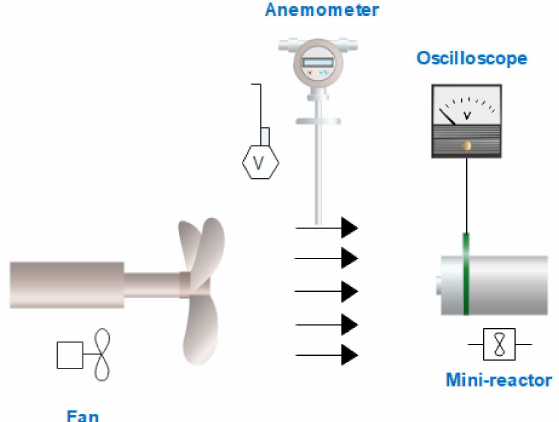
Figure 11. Test set-up diagram to measure wind power in open space for turbine